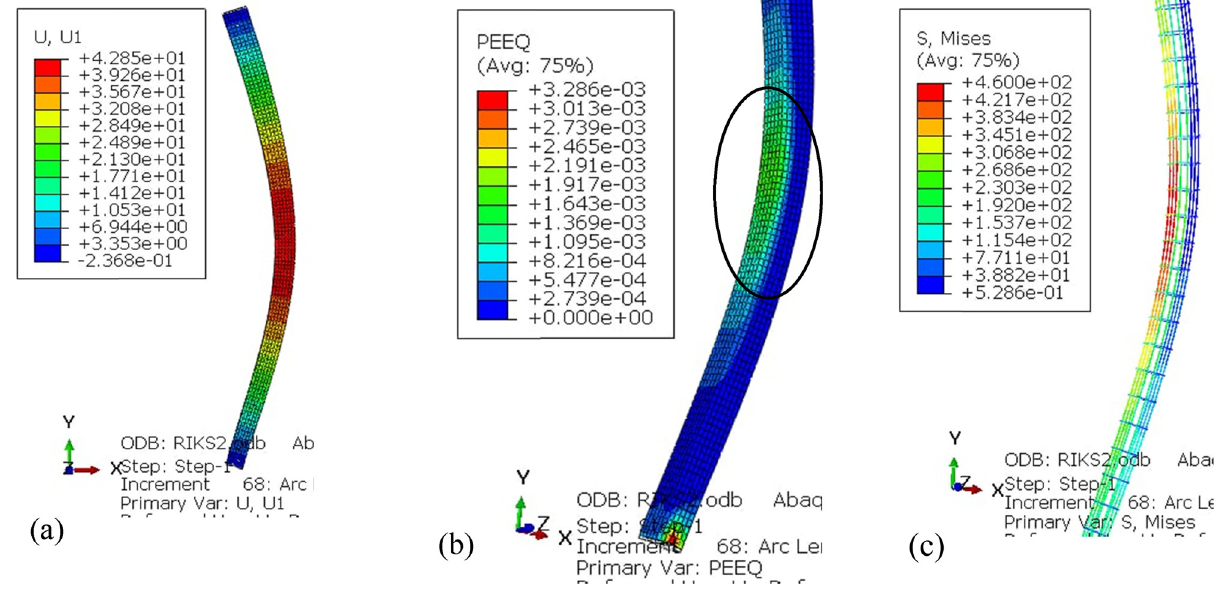
Figure 6: ( a ) Deformed shape, ( b ) plastic strains, and ( c ) stress in steel